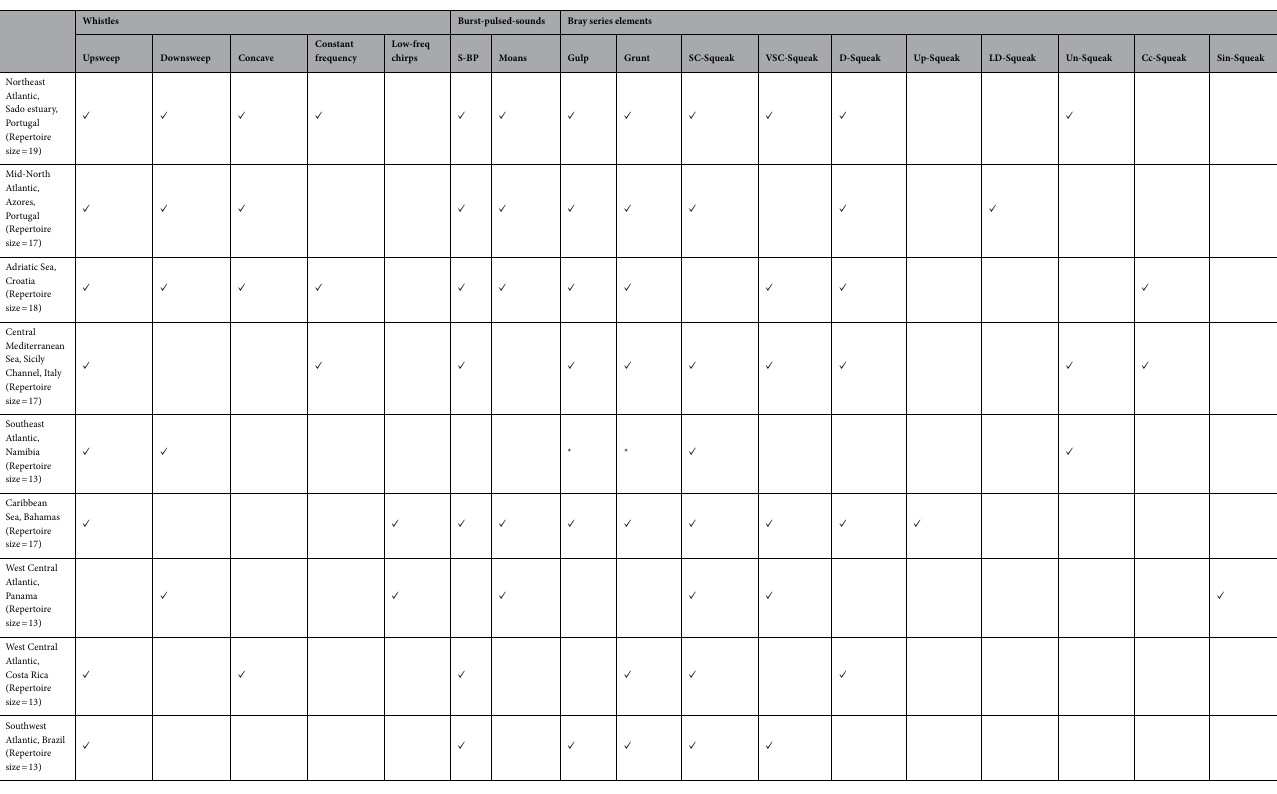
Table 2. Differences in signal sub-types occurrence. ✓ Present in the data collection. *Not present in the data collection but reported in previous